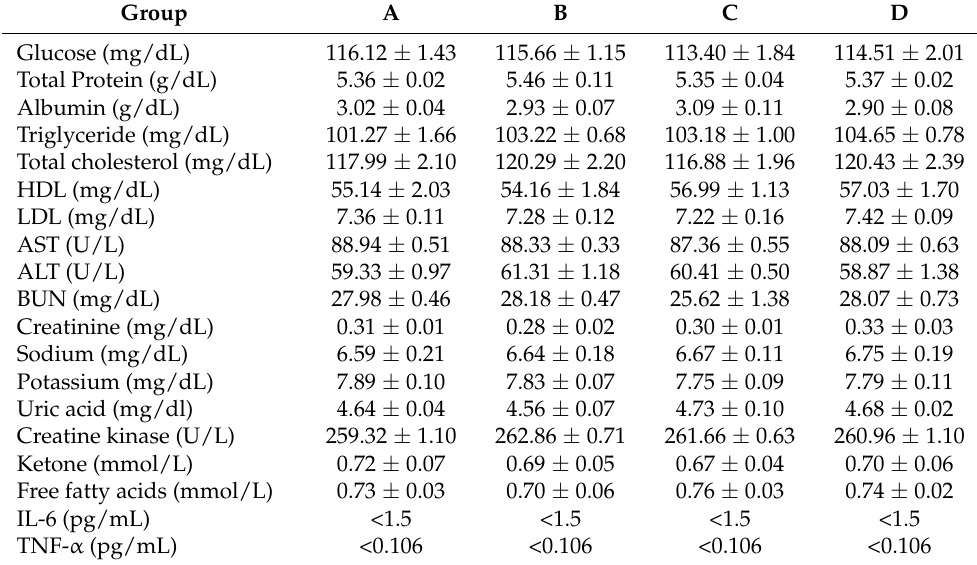
Table 8. Effects of SPE on serum biochemical parameters of female SAP8